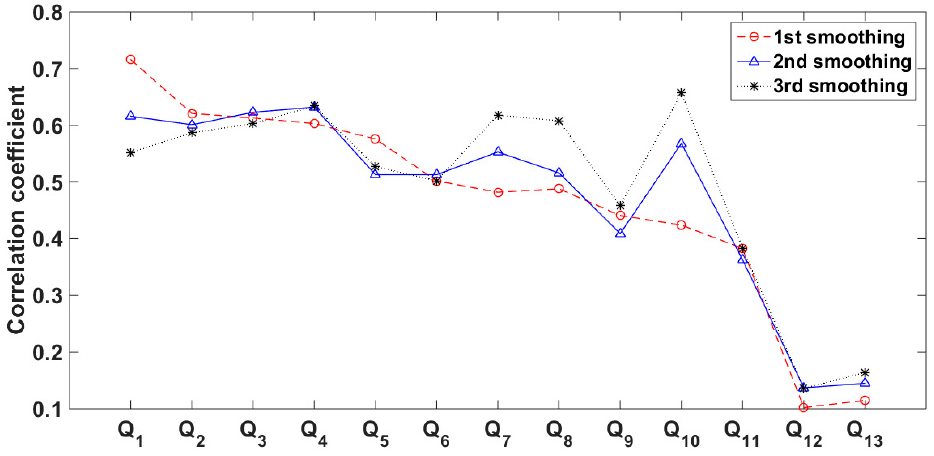
Figure 4. Changed correlation after smoothing